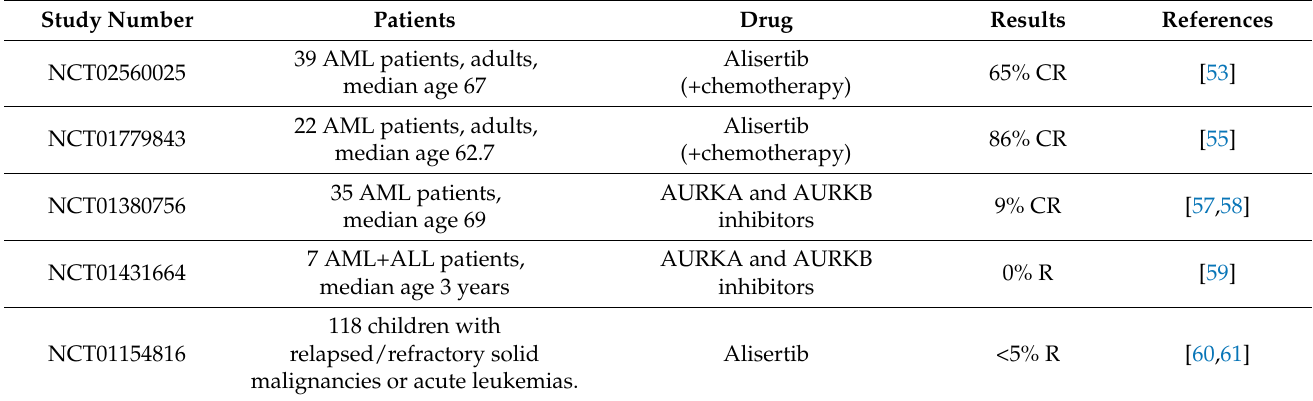
Table 2. Aurora kinase inhibitors